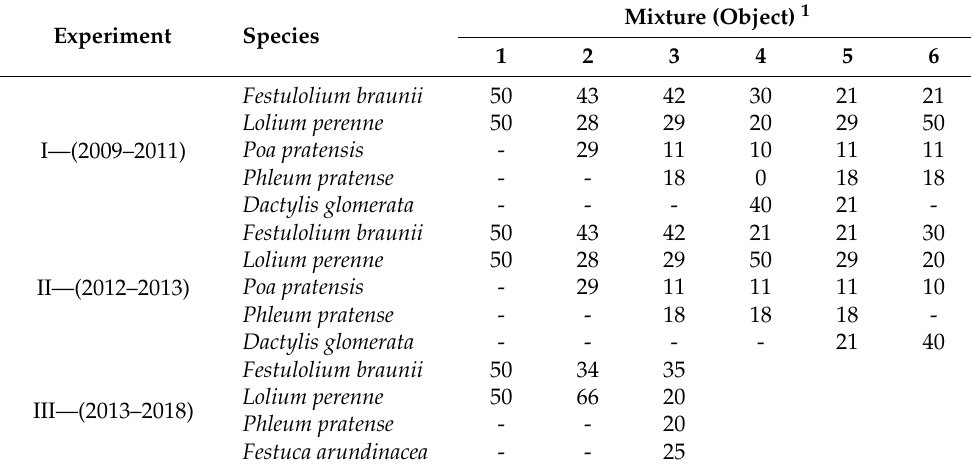
Table 3. Proportion of seeds of species in mixtures in % by weight in relation to the seeding standard of the